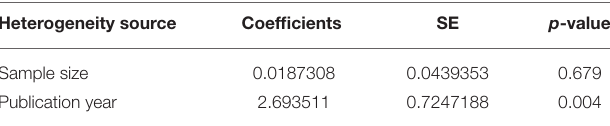
TABLE 1 | Meta-regression analysis of factors affecting between-study heterogeneity.